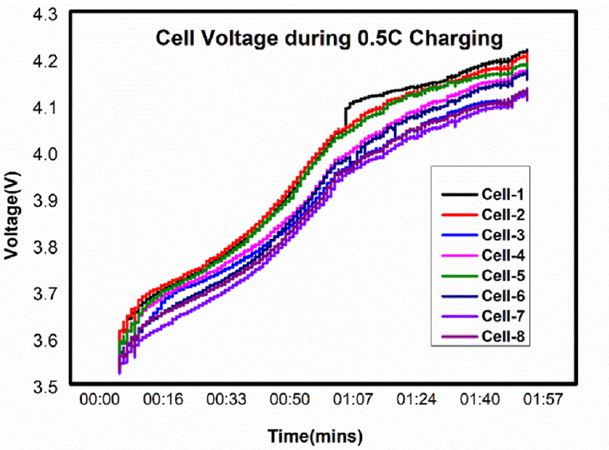
Figure 13. Charge curve plot for individual cells. The battery is charged with 0.5 C with starting and cutoff voltages range from 28.39 V to 33.4 V. The charging and discharging curves that are obtained are represented in the below Figures 14 and 15, respectively. During discharge, the starting and cutoff voltages ranges from 32.61 V to 25.22 V.